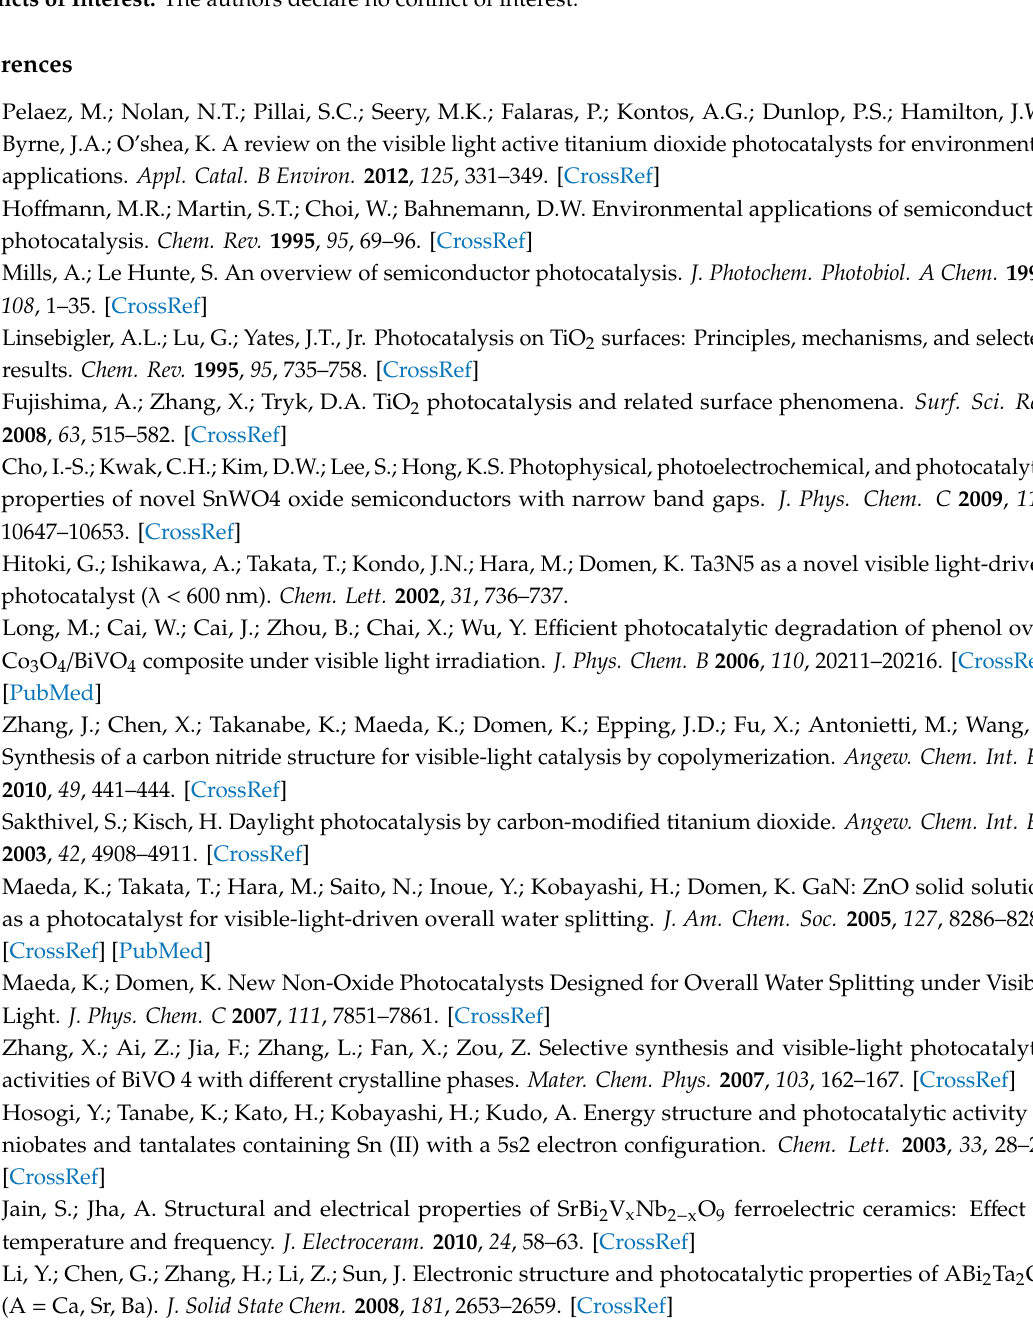
Figure S1: XRD patterns of SBNV06 powders calcined at 800, 850 and 900 ◦ C for 6 h, Figure S2: SEM images of (a) SNBV02, (b) SBNV04 and (c) SBNV08 samples, Figure S3: Variation of the absorbance of the RhB dye solution with time for (a) SBNV0, (b) SBNV02, (c) SBNV04, (d) SBNV06, (e) SBNV08, and (f) SBNV10 samples, Figure S4: (a) Pseudo first order reaction kinetics and (b) band-gap values, specific surface areas and reaction rate constants of the SBNV06 and WO 3 samples, Table S1: The BET surface area of samples, Table S2: Experimental and calculated bandgap values of